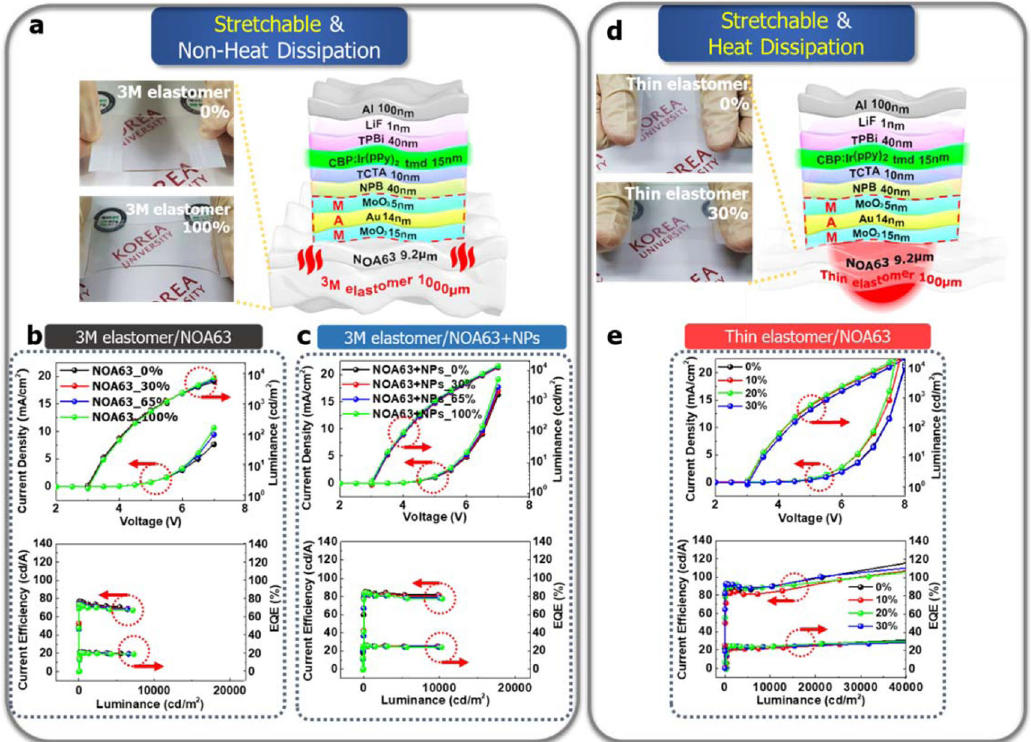
Fig. 3 Device performance of the stretchable and heat-dissipating devices based on MoO 3 /Au/MoO 3 (MAM) with and without SiO 2 NPs. a , d The schematic illustration of GSOLEDs and ‘ Stretchable & Non-Heat dissipating devices ’ with the 3 M elastomer, and ‘ Stretchable & Heat dissipating devices ’ with the thin elastomer, respectively. Insets of a, d, show camera image of the 3 M elastomer (0 and 100% strain) and the thin elastomer (0 and 30% strain). b Current density-voltage-luminance, current ef fi ciency, and quantum ef fi ciency analysis at various applied 2D strains with 3 M elastomer and Norland Optical Adhesive 63 (NOA63) fi lm. c With 3 M elastomer and NOA63 + silicon dioxide nanoparticles (SiO 2 NPs). e with thin elastomer. Table 1 Device performance (current ef fi ciency, power ef fi ciency, and external quantum ef fi ciency) of the GSOLED devices on thin Norland Optical Adhesive 63 (NOA63)/3 M elastomer substrate, with MAM electrode using isotropic and horizontal emitter at low luminance (500 cd/m 2 ).